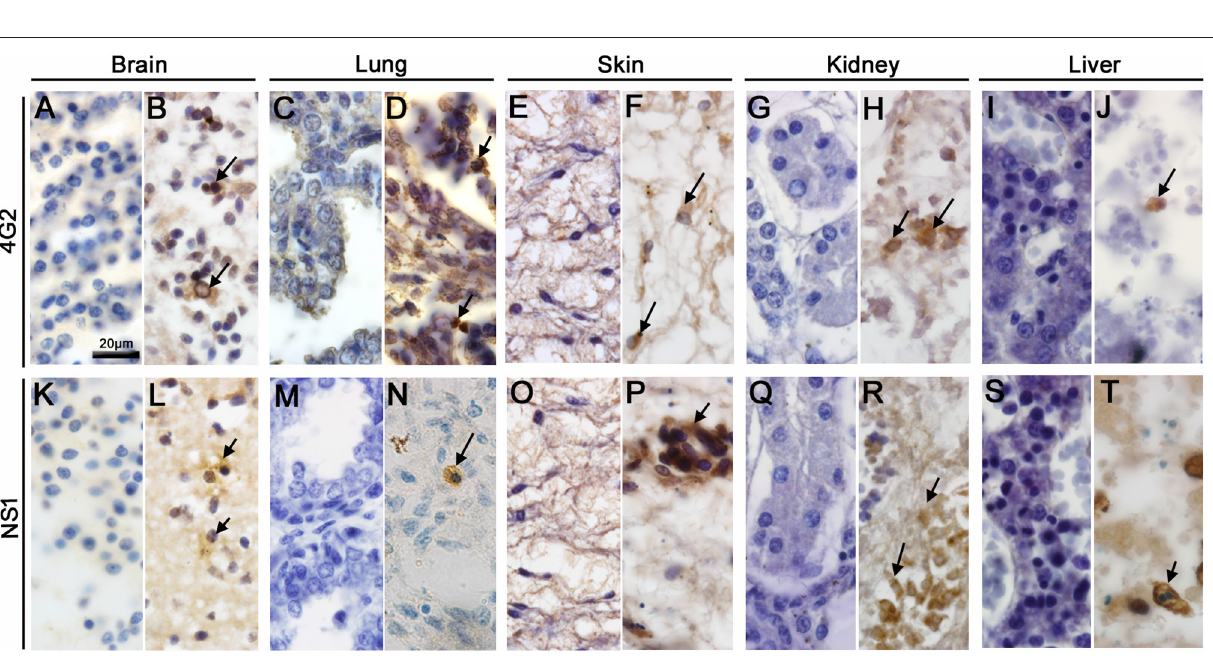
FIGURE 3 | diffuse mononuclear infiltrates (Inf) and peeled cells of respiratory epithelium (PC). (E) Skin dermis (DM) of a non-ZIKV case presenting normal aspect, epidermis (Epi), blood vessel (BV). (F) Skin dermis of a ZIKV infected fetus, with perivascular and mononuclear infiltrate (PInf and Inf) and areas of edema (E) . (G) Kidney of a non-ZIKV case presenting normal aspect, with normal glomerulus (GR) and proximal contorted tubules (PCT). (H) Kidney sections showing injuries, including: disorganized renal glomerulus (GR), tubular disarrangement and inflammatory infiltrate (Inf). (I) Section of a control liver, with normal bile duct (BD) and portal